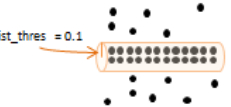
Figure 10. Cylinder radius for